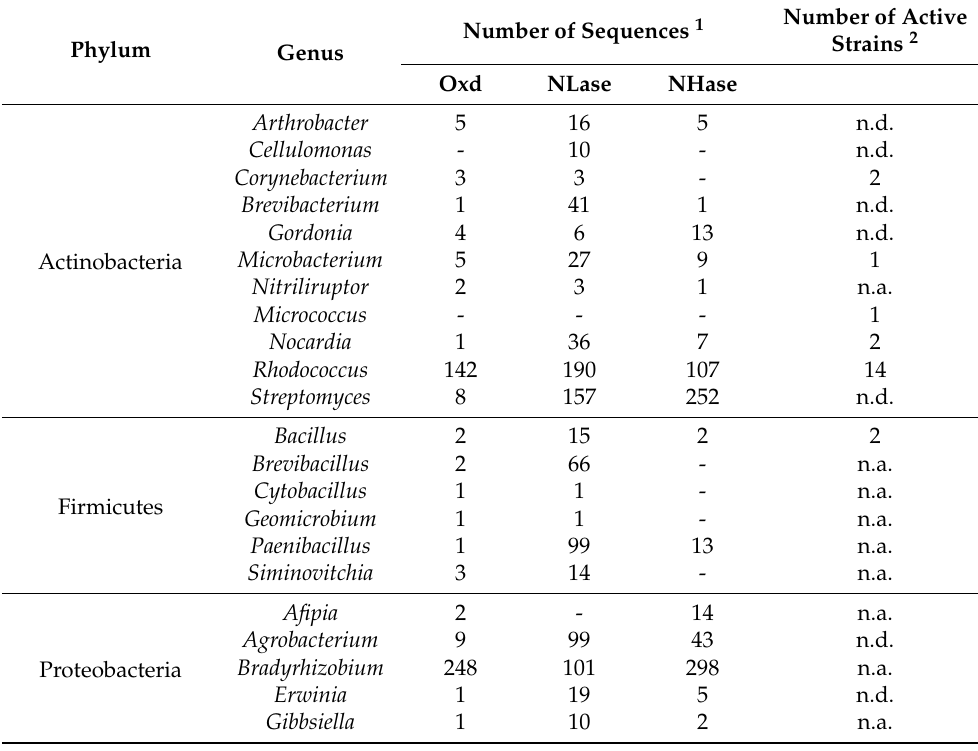
Table 3. Distribution of aldoxime dehydratases, nitrilases, and nitrile hydratases in bacteria.